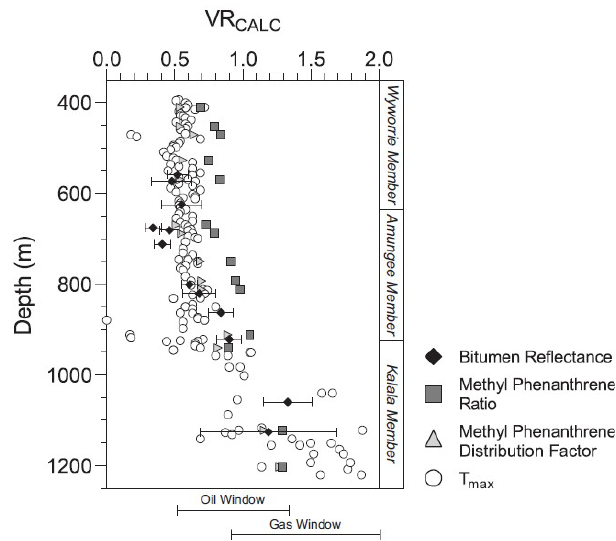
Figure 4. Calculated vitrinite reflectance (VR CALC ) data modelled downhole from T max , MPR, MPDF, and bitumen reflectance data compiled in this study (NTGS, 1989, 2009, 2010, 2012; Cox et al., 2016; Lemiux, 2011; Revie, 2014; Capogreco, 2017; Revie et al., 2022; Jarrett et al., 2019). VR CALC from all proxies indicate an el- evation in thermal maturity into the gas window at depths ca.